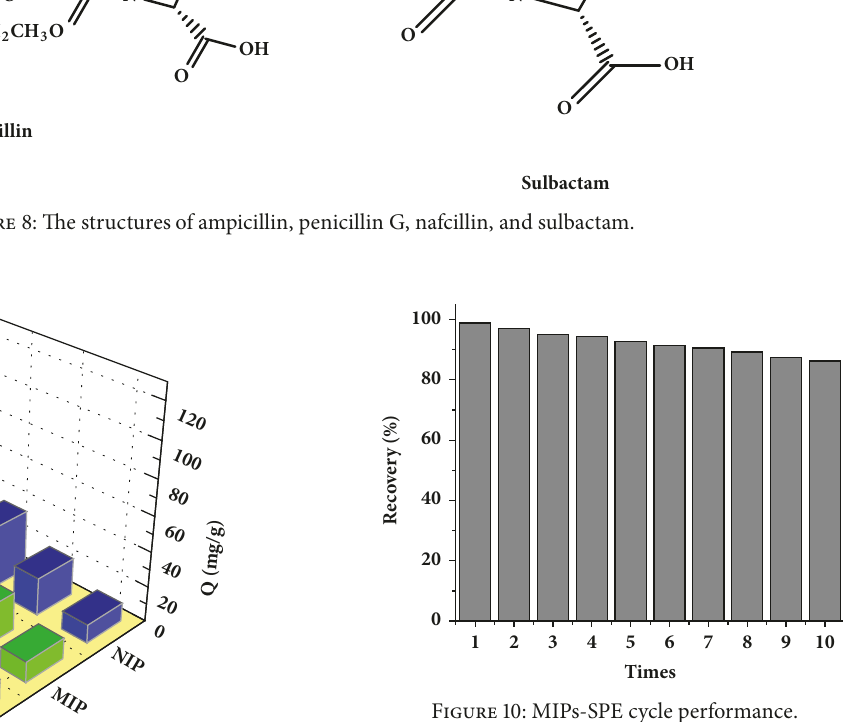
Figure 10: MIPs-SPE cycle performance. provides an important reference for further monitoring and research to improve food